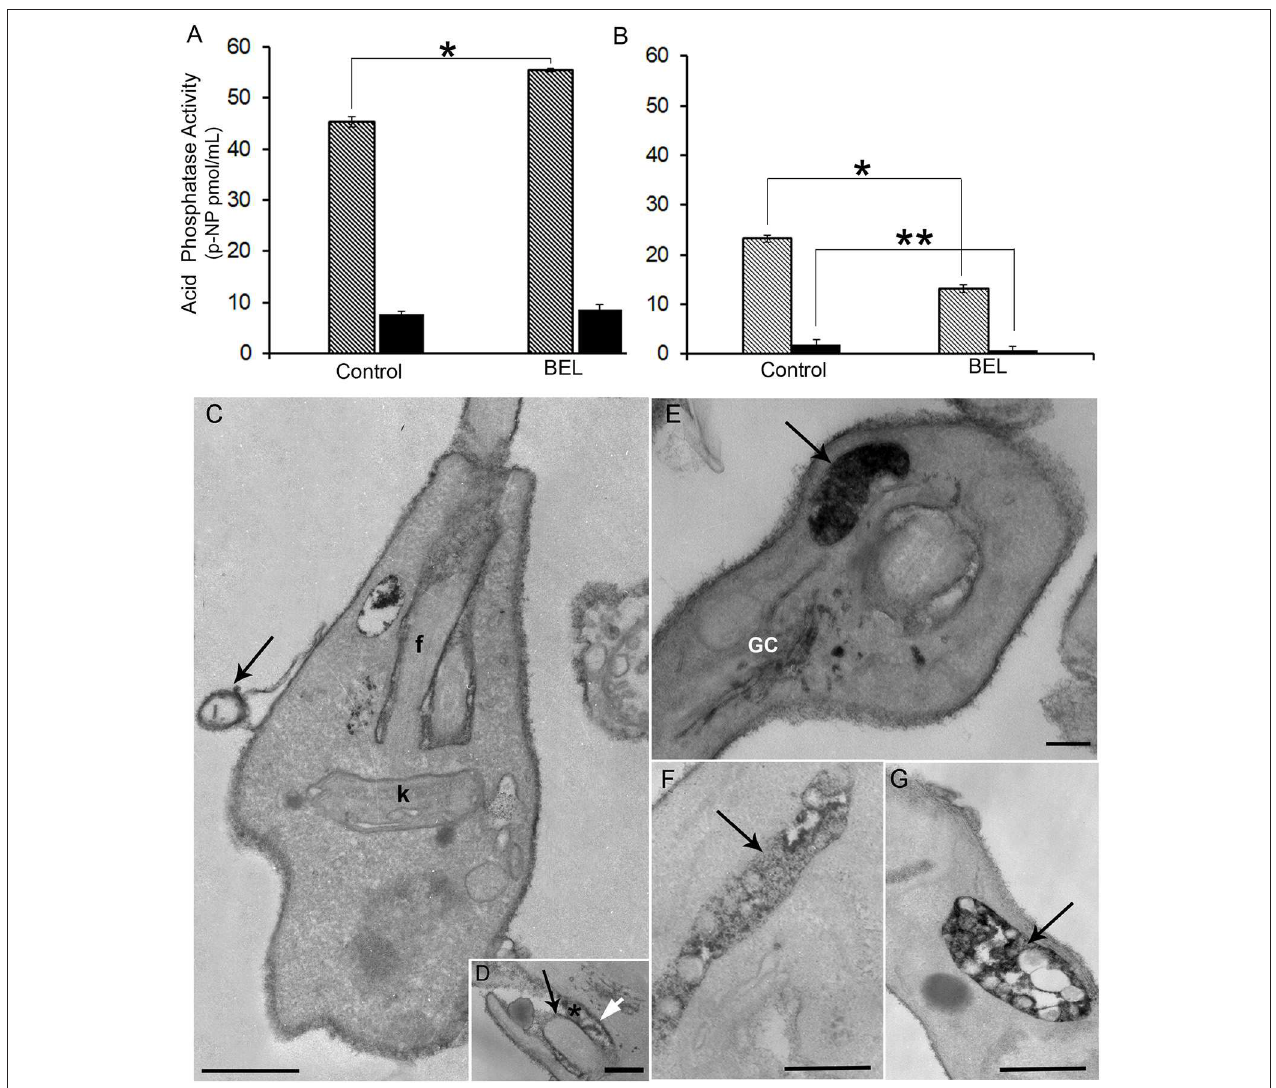
FIGURE 5 | Effect of bromoenol lactone (BEL) on the acid phosphatase activity and localization in promastigotes of Leishmania amazonensis. Quantitative analysis of acid phosphatase activity of (A) promastigotes and (B) conditioned media assayed in the presence or absence of sodium tartrate, in intact BEL-treated and untreated cells, and in conditioned media of untreated control cells and those incubated for 1h in the presence of BEL as described in the Methods section. Data shown as p-nitrophenyl (p-NP) released, represent mean ± SEM of three independent experiments performed in triplicates. Hatched bars = Na-tartrate sensitive and black bars = Na-resistant tartrate phosphatases. * p < 0.05; ** p < 0.01. (C–G) Cytochemical detection of acid phosphatases in control (C,D) and in BEL-treated parasites (E,G) , using sodium β -glycerophosphate as a substrate. In control parasites, electron dense precipitate indicative of acid phosphatase activity is localized mainly in the cell body, in the flagellar membrane (black arrow in D ), in the membrane of microvesicles (arrow in C ), in the membrane of the flagellar pocket (white arrow in D ) and within the flagellar pocket (asterisk in D ). In BEL-treated promastigotes acid phosphatase activity was also observed in the Golgi complex (GC), and concentrated in multivesicular tubules (MVTs, arrows in E,F,G ). f, flagellum; K, kinetoplast. Representative images of three independent experiments. Bars, 300nm.